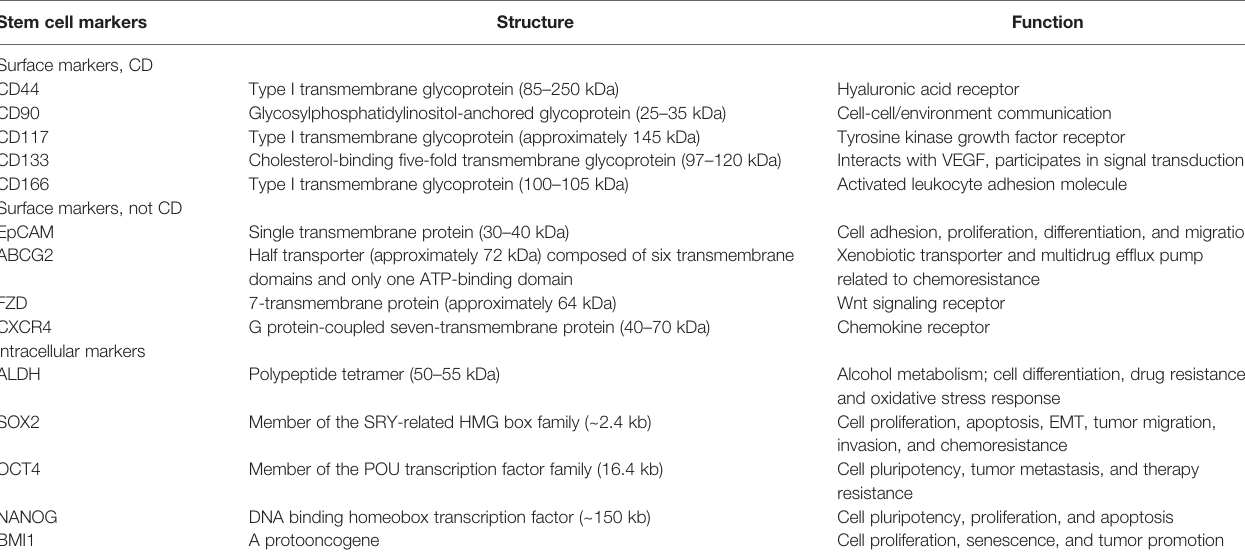
TABLE 1 | Potential non-small cell lung cancer stem cell markers, structures, and